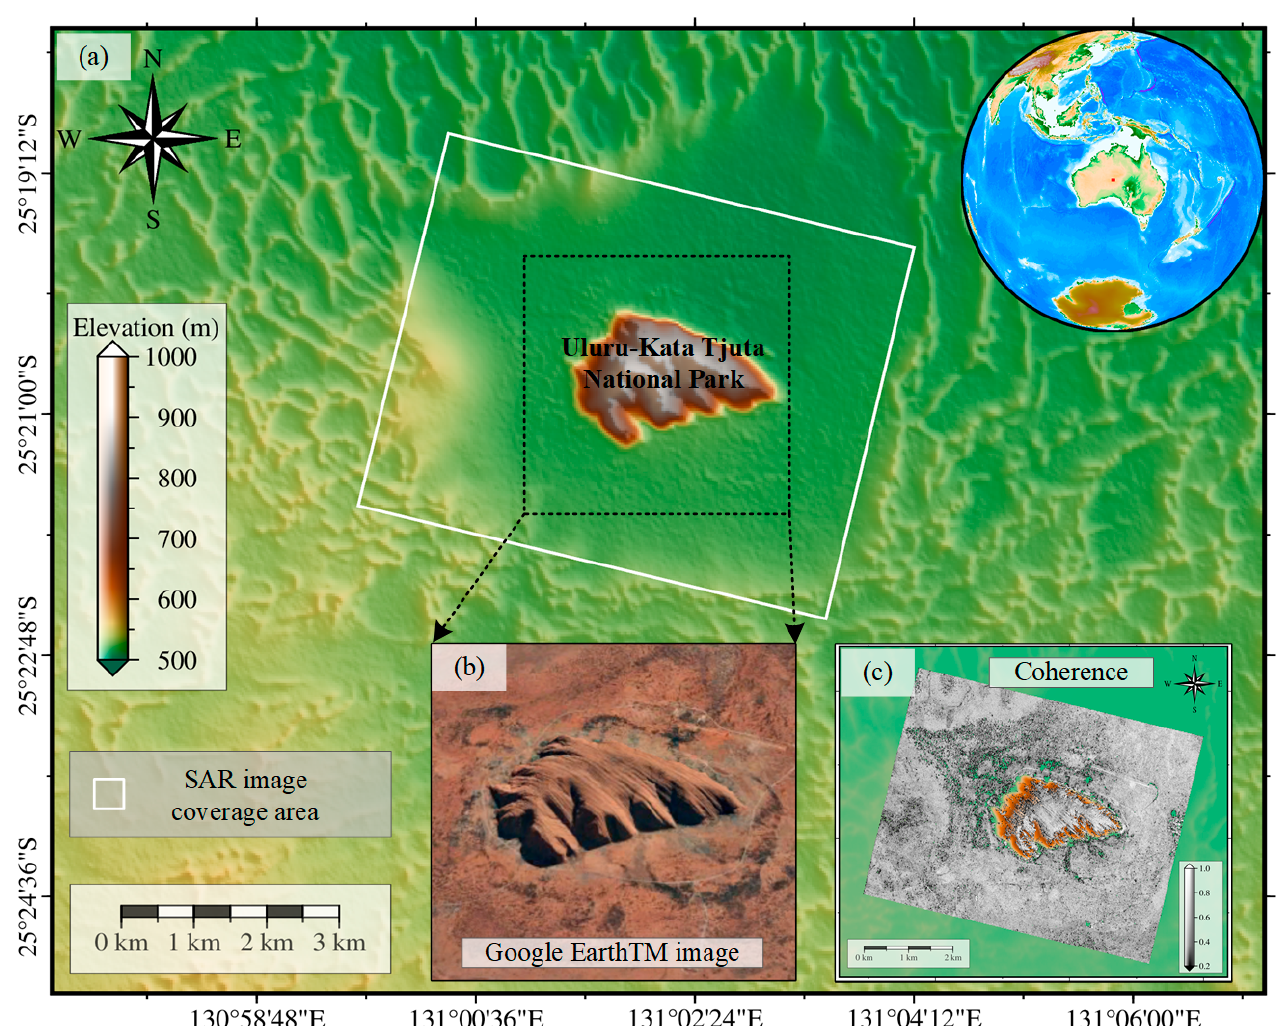
Figure 3. The study area: ( b ) represents the google image of the black dotted rectangle in ( a ), ( c ) is the coherence of the pair of TerraSAR-X images.